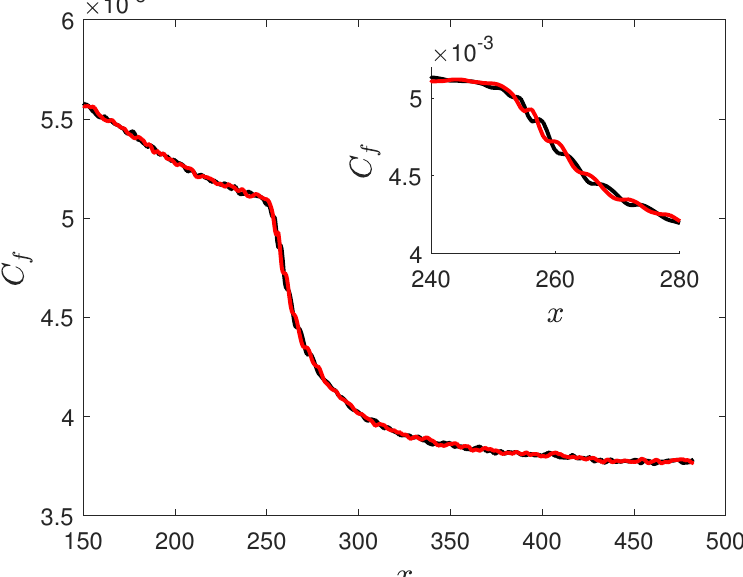
Figure 6. Skin friction coefficient for temporal oscillating wall with period T + = 30 at two different phases (black line φ = 0 ◦ and red line φ = 90 ◦ ). Inset is an enlargement to visualise small-amplitude wave occurring immediately downstream of start-point of